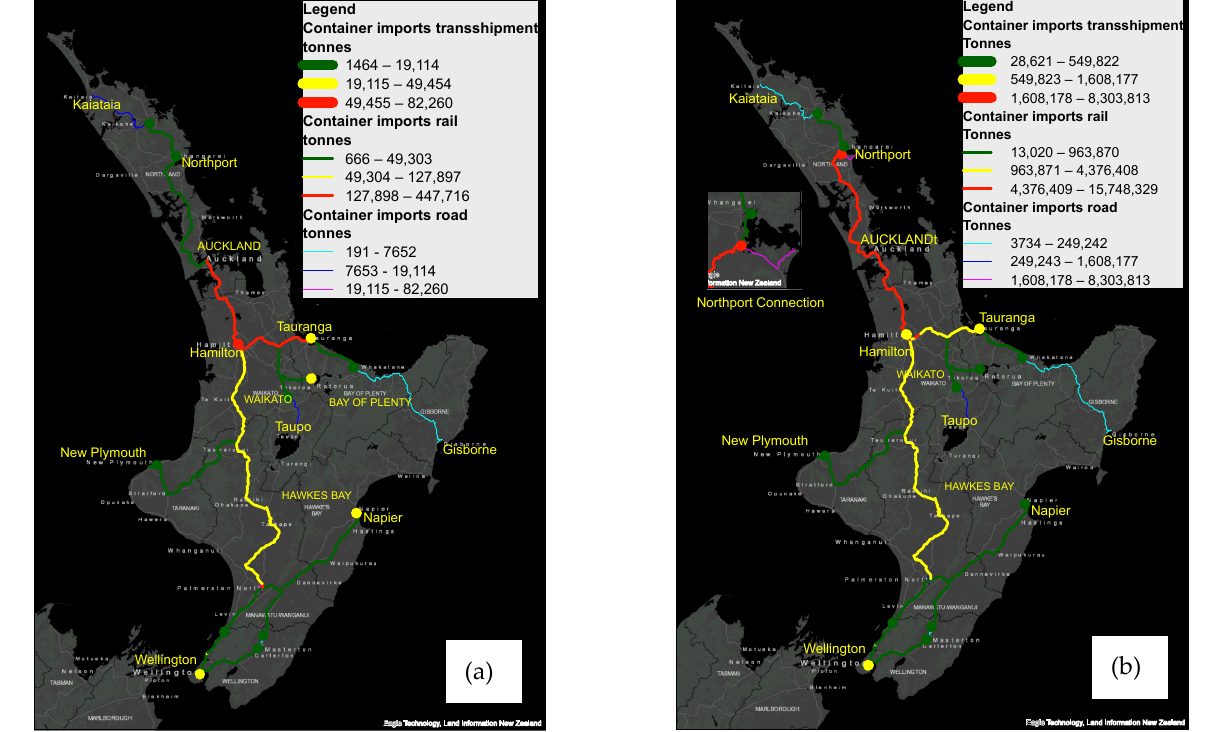
Figure 8. Road and rail movements for container imports in ( a ) BAU-NC-E and ( b ) FS-NC-E scenarios.